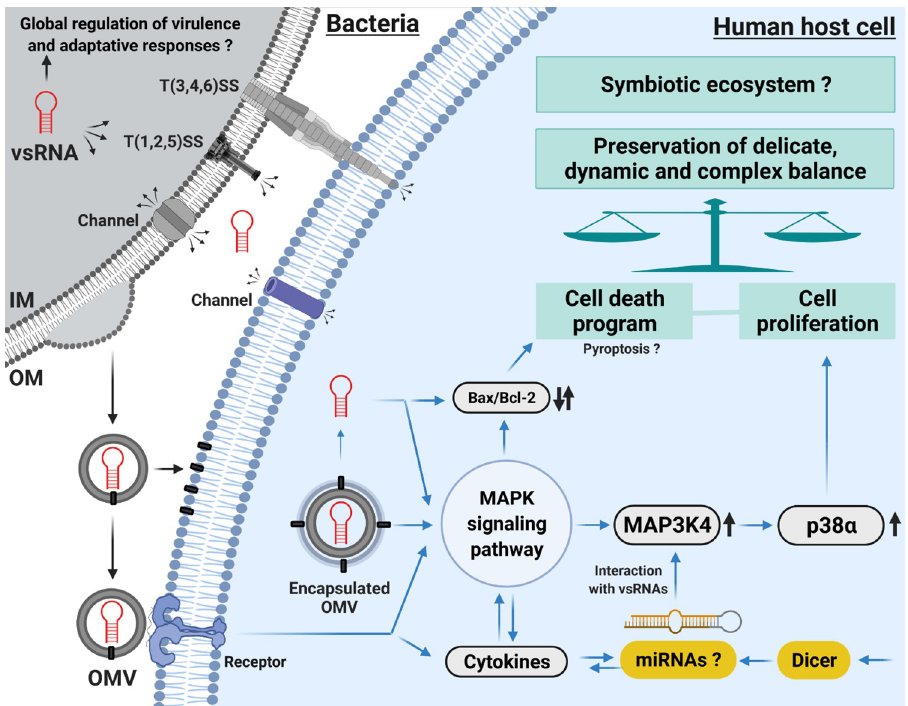
Fig 12. Schematic representation of how bacterial OMVs and their content in vsRNAs, such as Ile-tRF-5X, may be involved in preserving the delicate, dynamic and complex balance of homeostasis. IM = Inner Membrane; OM = Outer Membrane; OMV = Outer Membrane Vesicle; T(1,2,3,4,5,6)SS = Type (1,2,3,4,5,6) Secretion System. Original figure created with BioRender.com based on our previous review [27]. Not drawn to